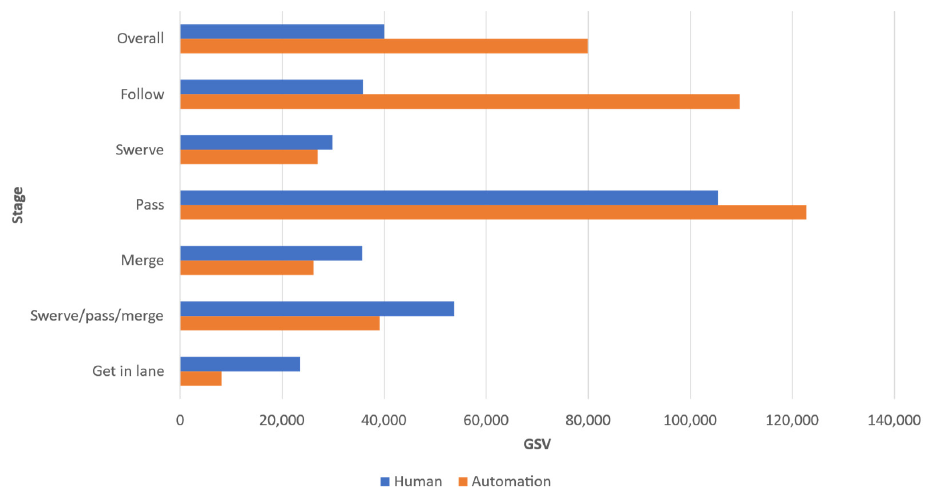
Figure 9. Comparison of the GSV for the overall system and per stage between human and automation.